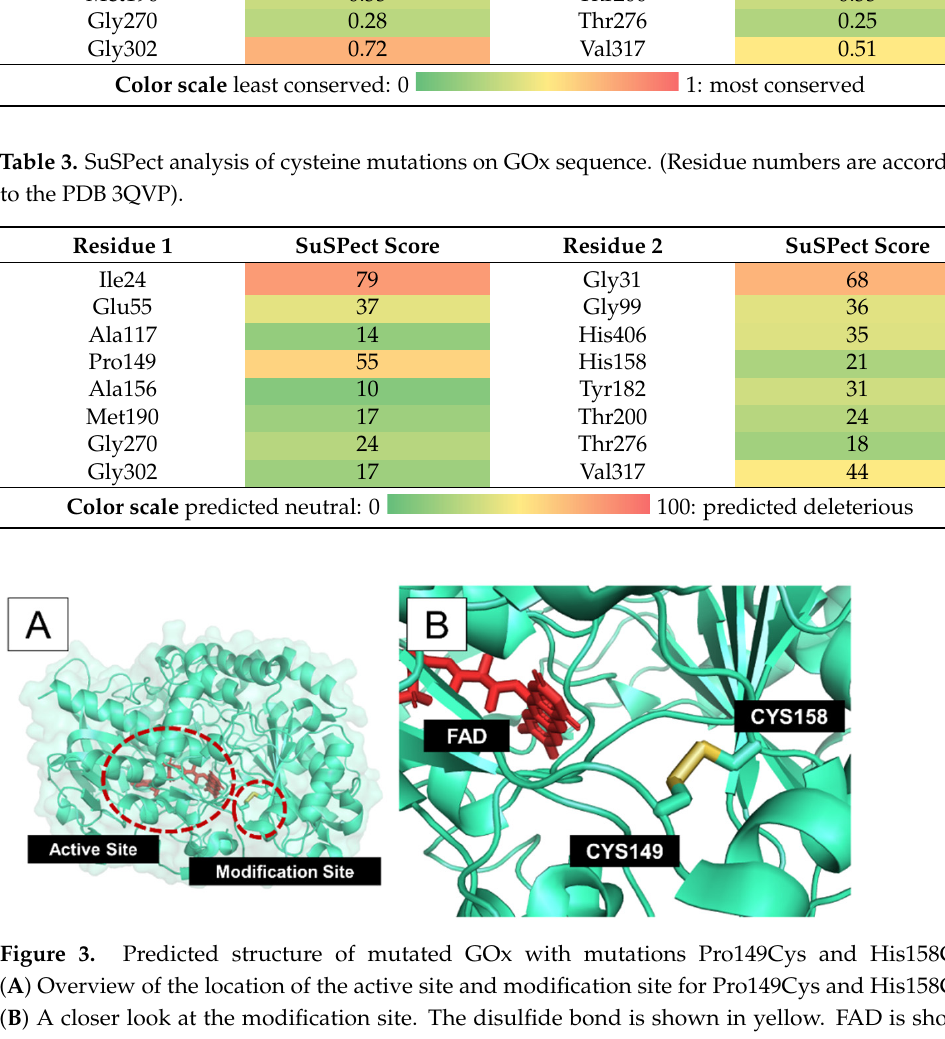
Table 3. SuSPect analysis of cysteine mutations on GOx sequence. (Residue numbers are accord- ing to the PDB 3QVP).